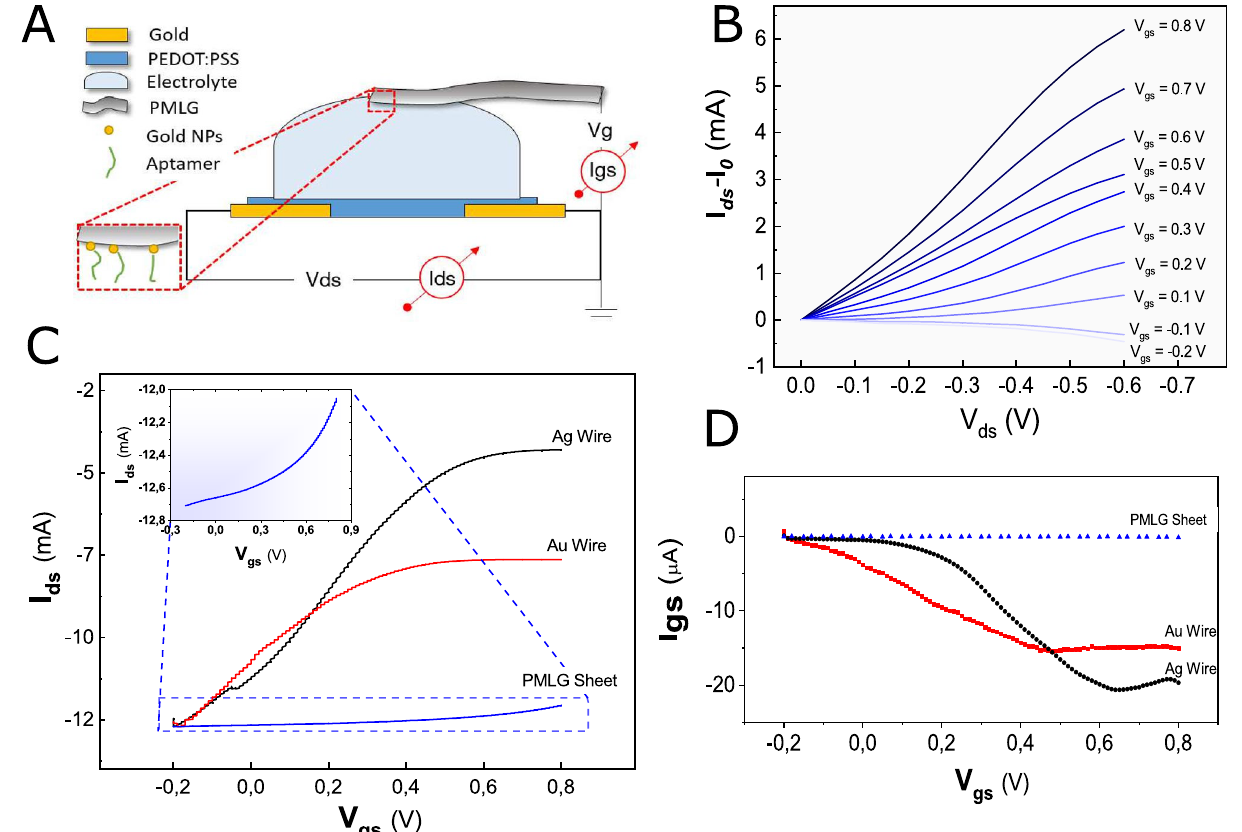
Figure 1. ( A ) layout of the PMLG gated OECT; ( B ) related I ds — I 0 versus V ds (from 0 to − 0.6 V) recorded using PBS 10 mM as electrolyte (here, I 0 is the current measured at V ds = 0 V) and fixing V gs in the range − 0.2 to 0.8 V, step 0.1 V, for each curve; ( c ) PMLG OECT’s transfer characteristics obtained at V ds = − 0.25 V for different types of gate electrodes and ( D ) related gate currents (Ag wire -black line, Au wire—red line and PMLG sheet— blue line). The inset of ( C ) shows a magnification of PMLG